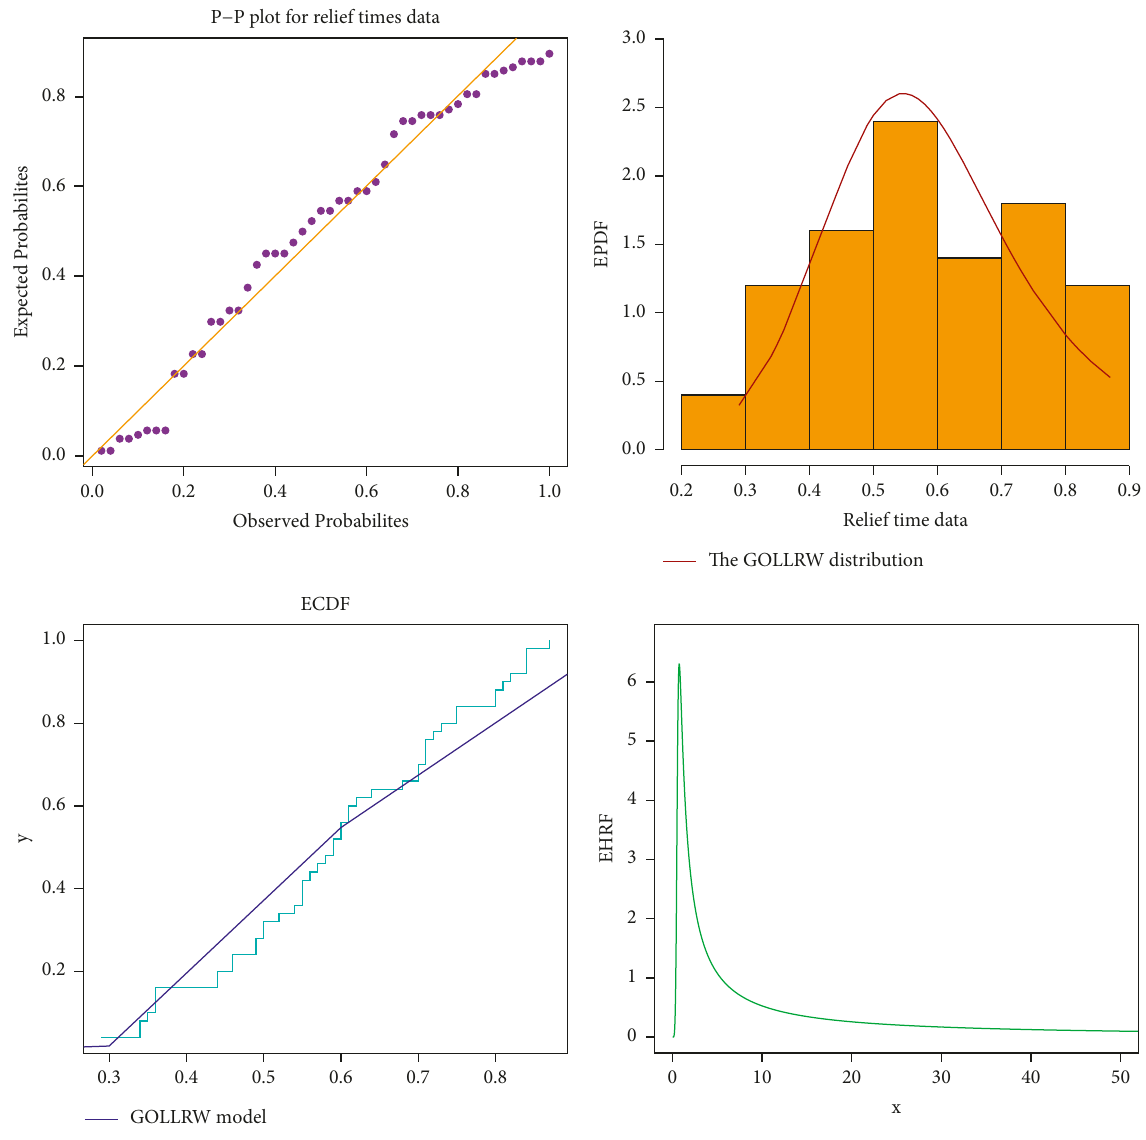
Figure 8: P-P plot, EPF, ECDF, and EHRF for relief time data set.